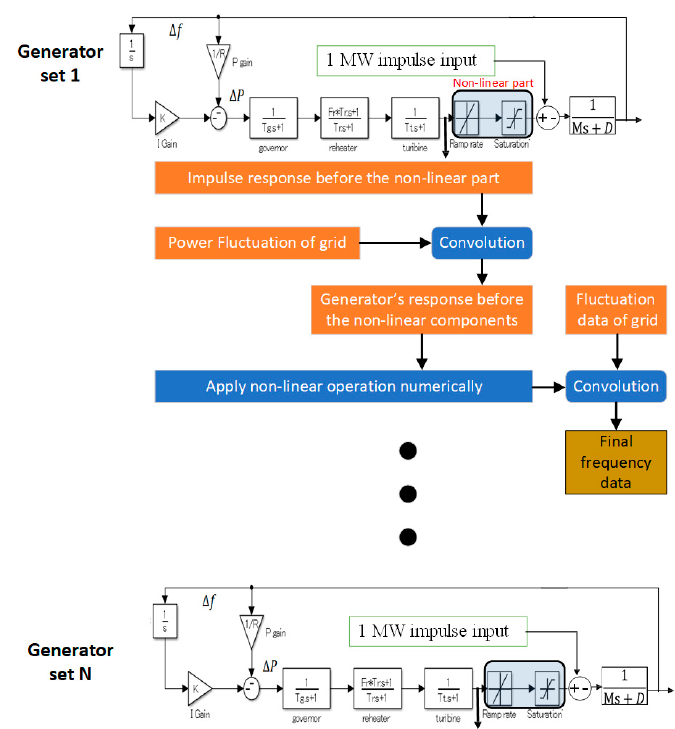
Figure 8. A hybrid-impulse response model.